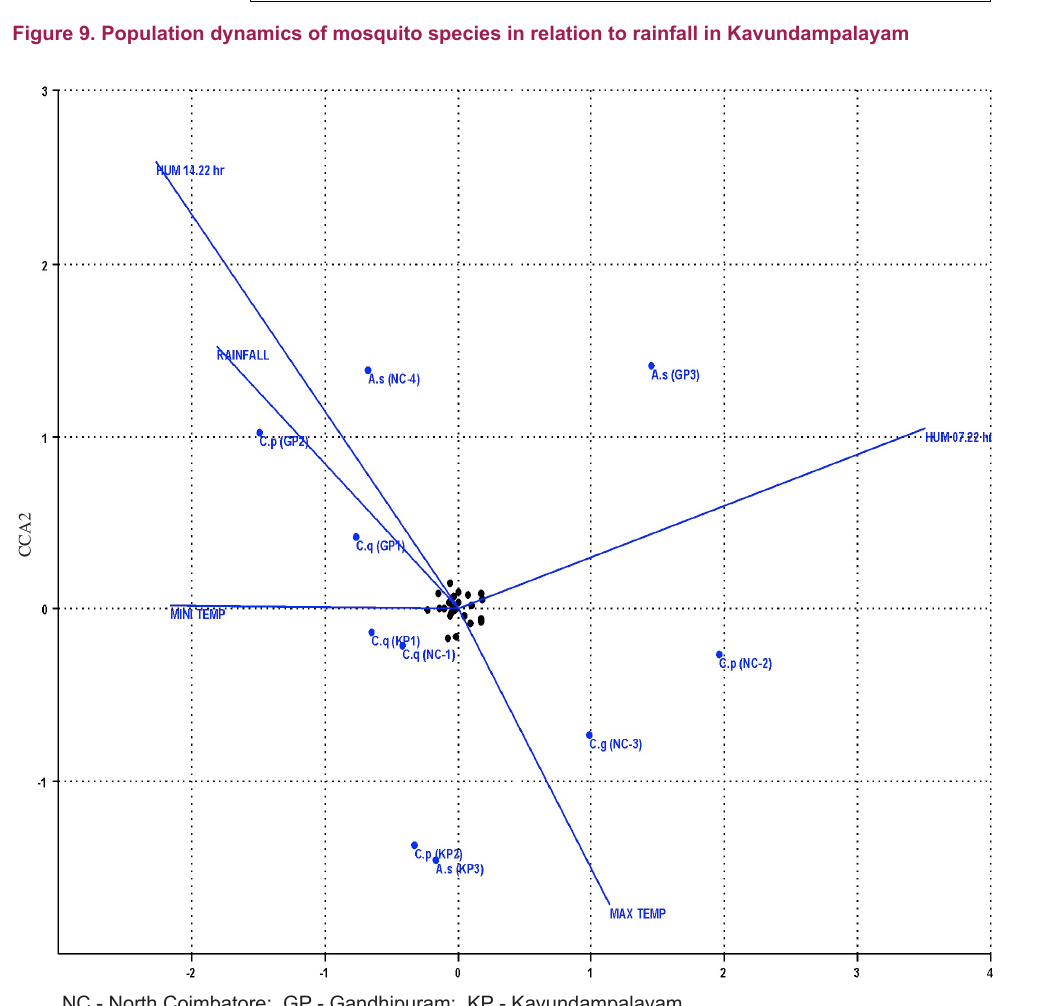
NC - North Coimbatore; GP - Gandhipuram; KP - Kavundampalayam C.q. - Culex quinquefasciatus; C.p. - Culex pseudovishnu; C.g. - Culex gelidus; A.s. - Armigeres Figure 10. Cano plot showing the distribution of mosquito populations from three areas of Coimbatore from November 1999 – October 2001